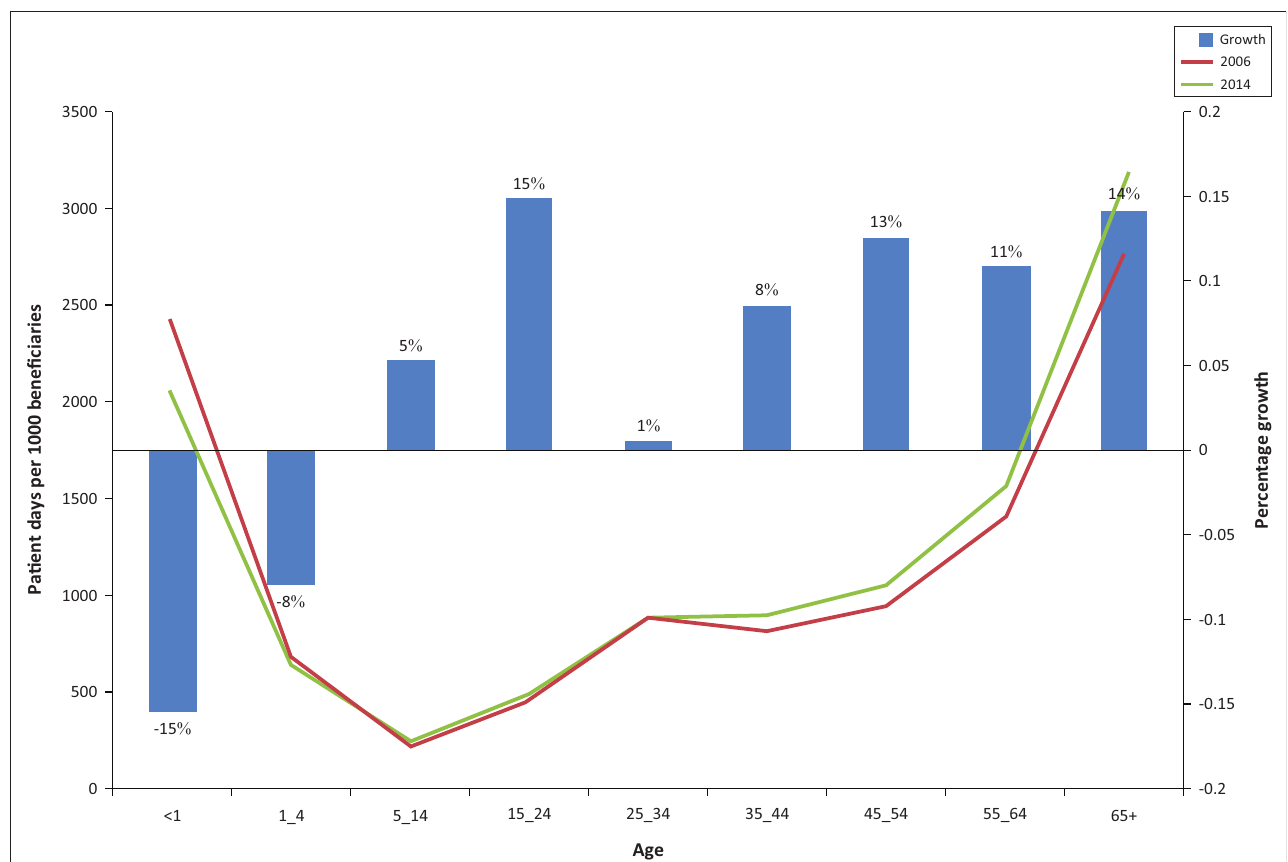
FIGURE 6: Patient days per age group, per 1000 beneficiaries, 2006 and